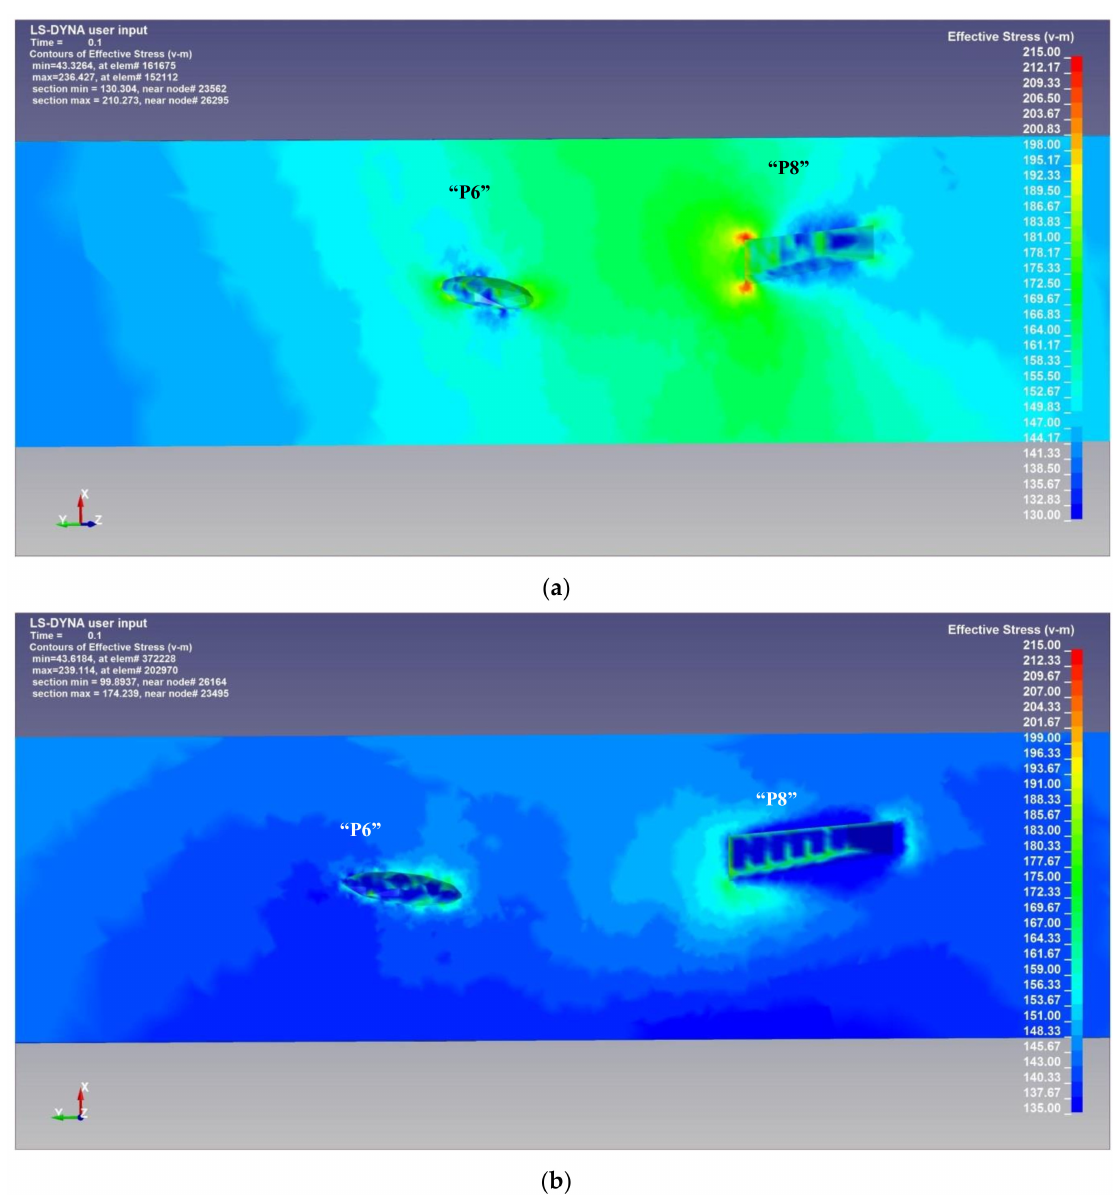
Figure 17. Comparison between the induced stress fields of “P6” and “P8” (units in MPa): ( a ) first loading scenario and ( b ) second loading